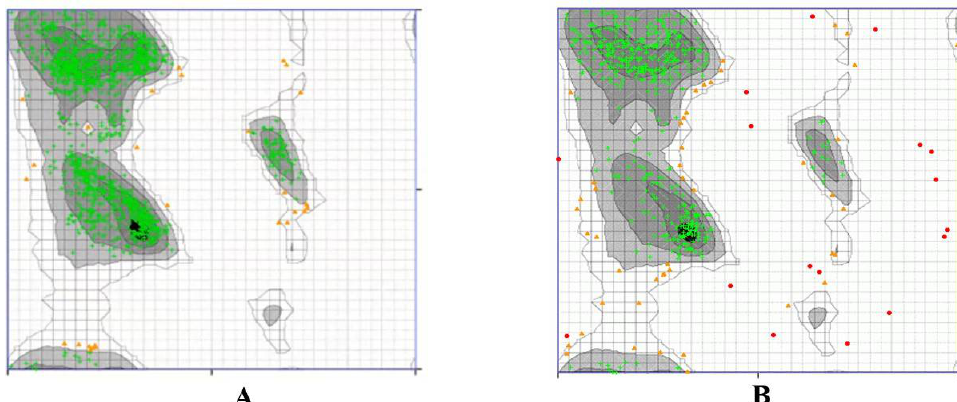
Figure 4. Ramachandran plot by Zlab of the defined binding site in ( A ) TLR4 and ( B ) p50. The green crosses represent the amino acid residues and are indicative of highly preferred observations; the brown triangles denote preferred observations, and the red circles denote outliers.